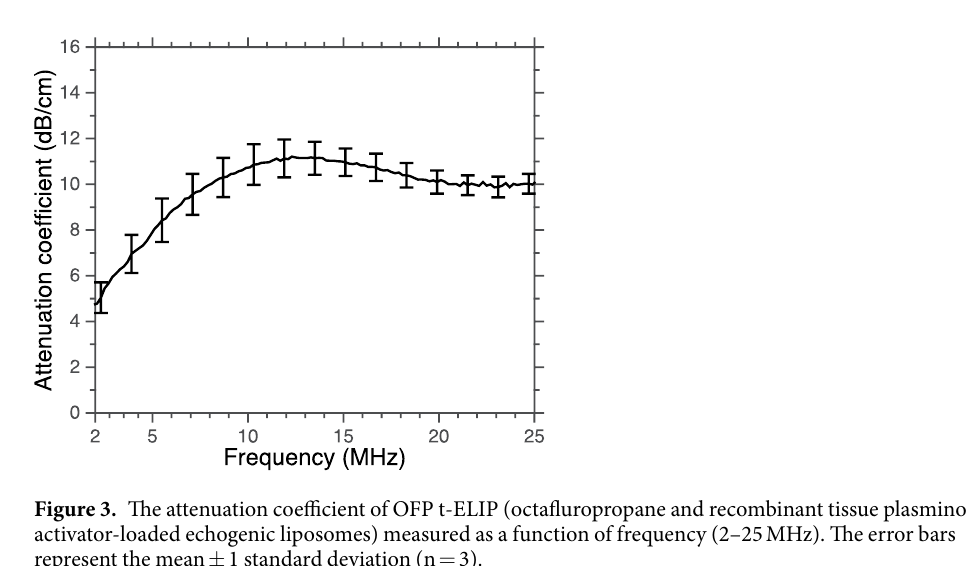
Figure 2. The number- (left ordinate) and volume-weighted (right ordinate) size-distributions of OFP t-ELIP (octafluropropane- and recombinant tissue plasminogen activator-loaded echogenic liposomes). The error bars represent the mean ± 1 standard deviation (n = 3).